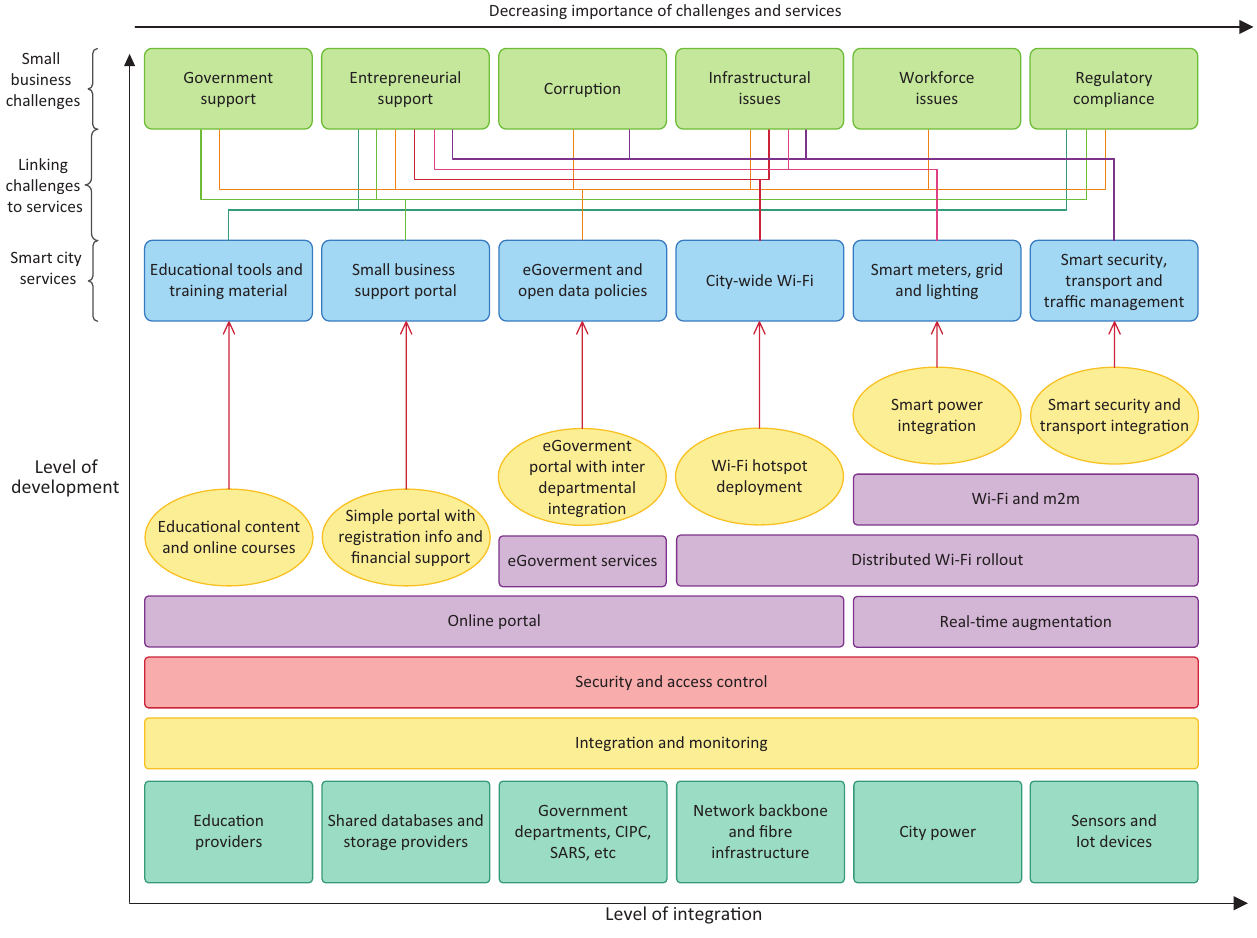
FIGURE 11: Proposed smart city roadmap for supporting small businesses.